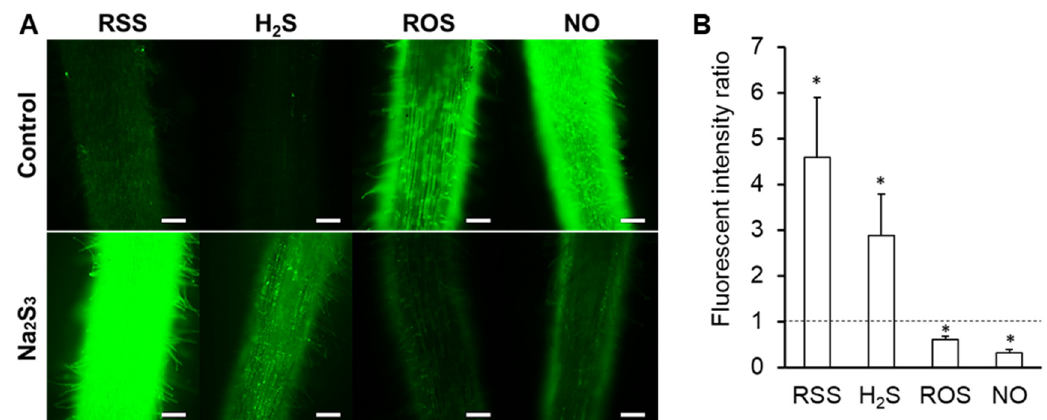
Figure 2. Effect of Na 2 S 3 on the amount of nitric oxide (NO), reactive oxygen species (ROS), and hydrogen sulfide (H 2 S) in roots of L. japonicus MG-20. ( A ) Fluorescence microscopy images of root tissue, showing signal molecules. Seedlings were incubated with Na 2 S 3 for 1 h prior to incubation with each specific probe. Scale bars, 100 μ m. ( B ) Fluorescence intensity was quantified by using the image analysis software Image J. Fluorescence intensity of Na 2 S 3 -treated roots is expressed relative to that of untreated roots (control) which was set at 1, indicated by the dashed line. Values indicate means (± SE; n = 30). Asterisks denote statistically significant differences compared to the control (Student’s t -test, * p < 0.05).